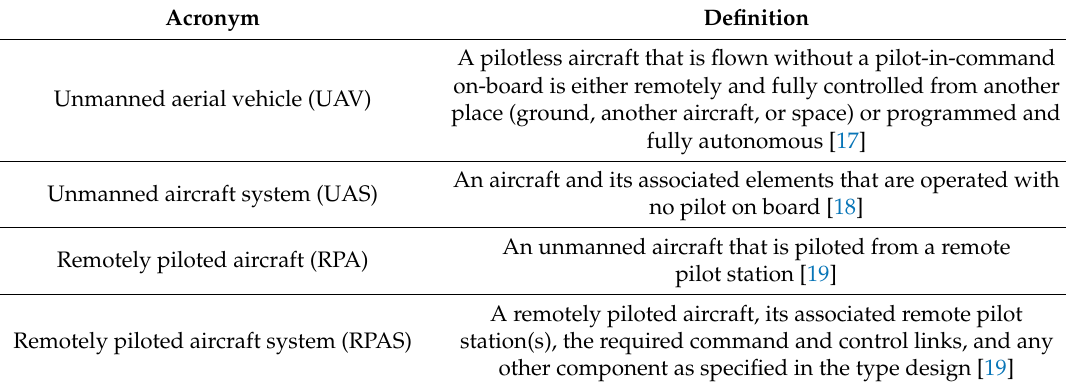
Table 1. Term glossaries indicating aerial-vehicle systems that are remotely controlled without human